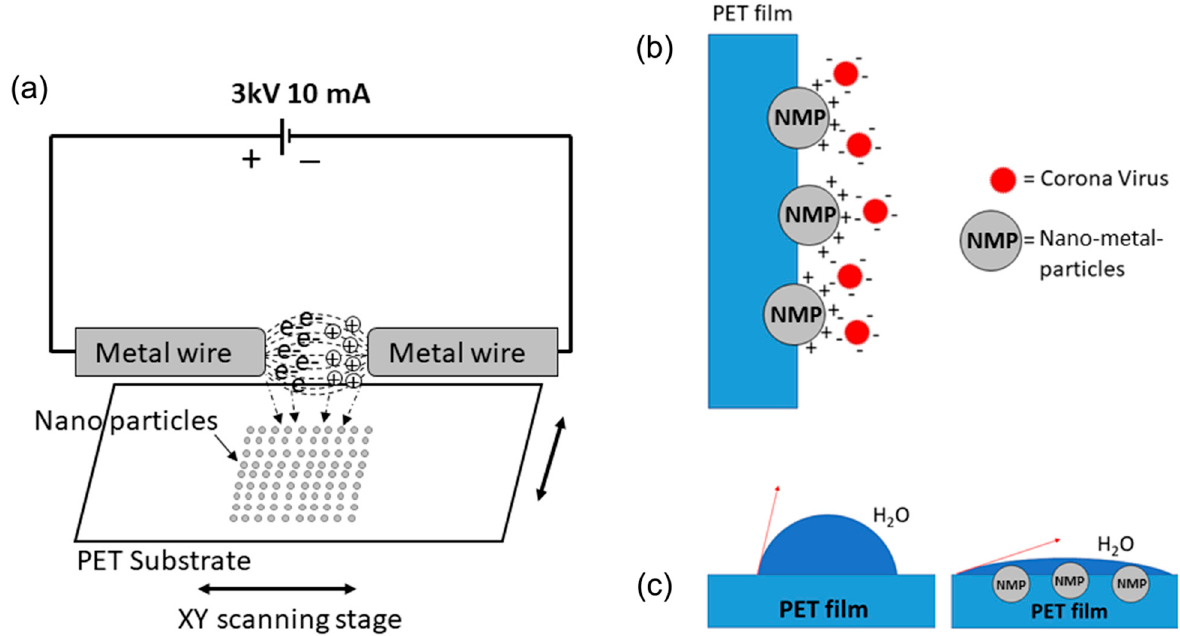
Figure 1. Schematic illustrations of the nano-metal-coated PET surface using the sparking technique ( a ) schematic diagram of the sparking apparatus for PET film, ( b ) schematic of the nano-metal particles deposited on the PET surface and coronavirus binding, ( c ) schematic of the reduced surface tension with the deposited NP.